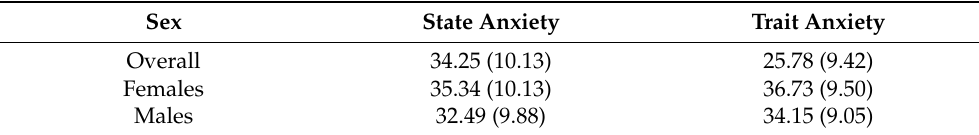
Table 4. State and Trait Anxiety Raw Scores. [M